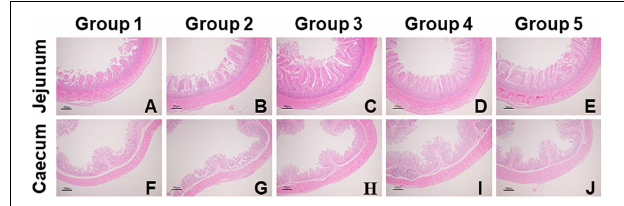
FIGURE 1 | Representative images of jejunal (A–E) and cecal (F–J) morphology of experimental ducks in different groups (40 × magnification). Intestinal issue samples were processed with hematoxylin and eosin